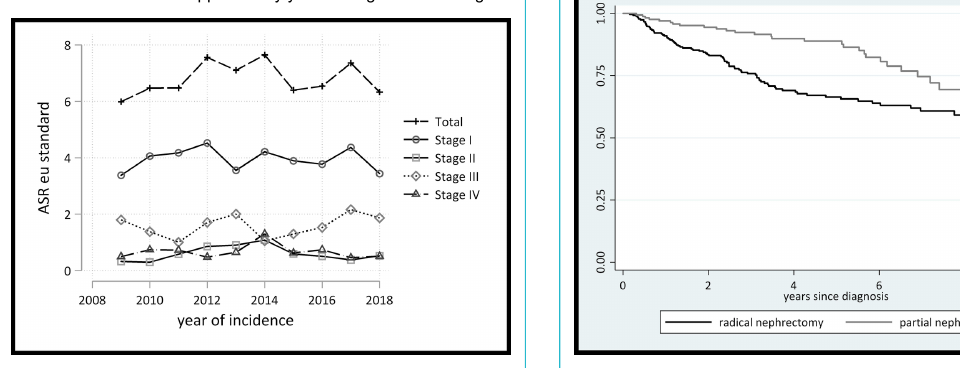
Figure 2: Age-standardised incidence rates (ASR) of renal cell carcinoma in St Gallen-Appenzell by year of diagnosis and stage.